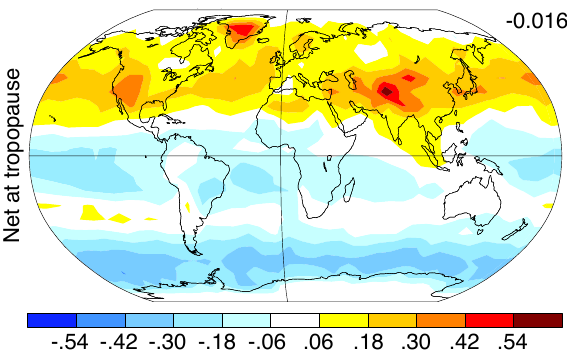
Fig. 14. Difference in tropopause RF (W m − 2 ) calculated using modeled (E2-R) and TES tropospheric ozone. The global mean value is in the upper